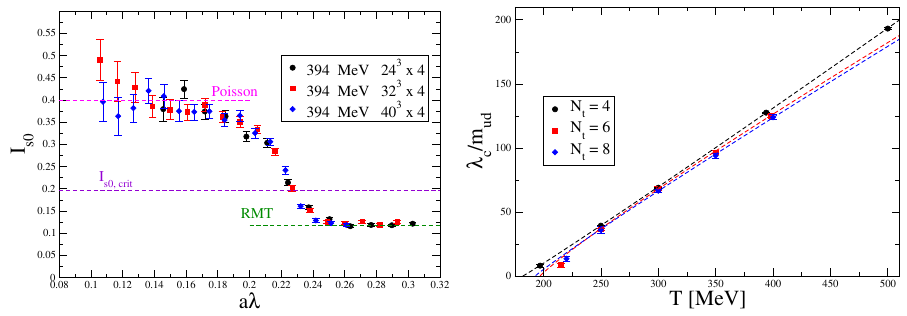
× N ff erent t lattices of di s [8] are also shown. Right: s 0